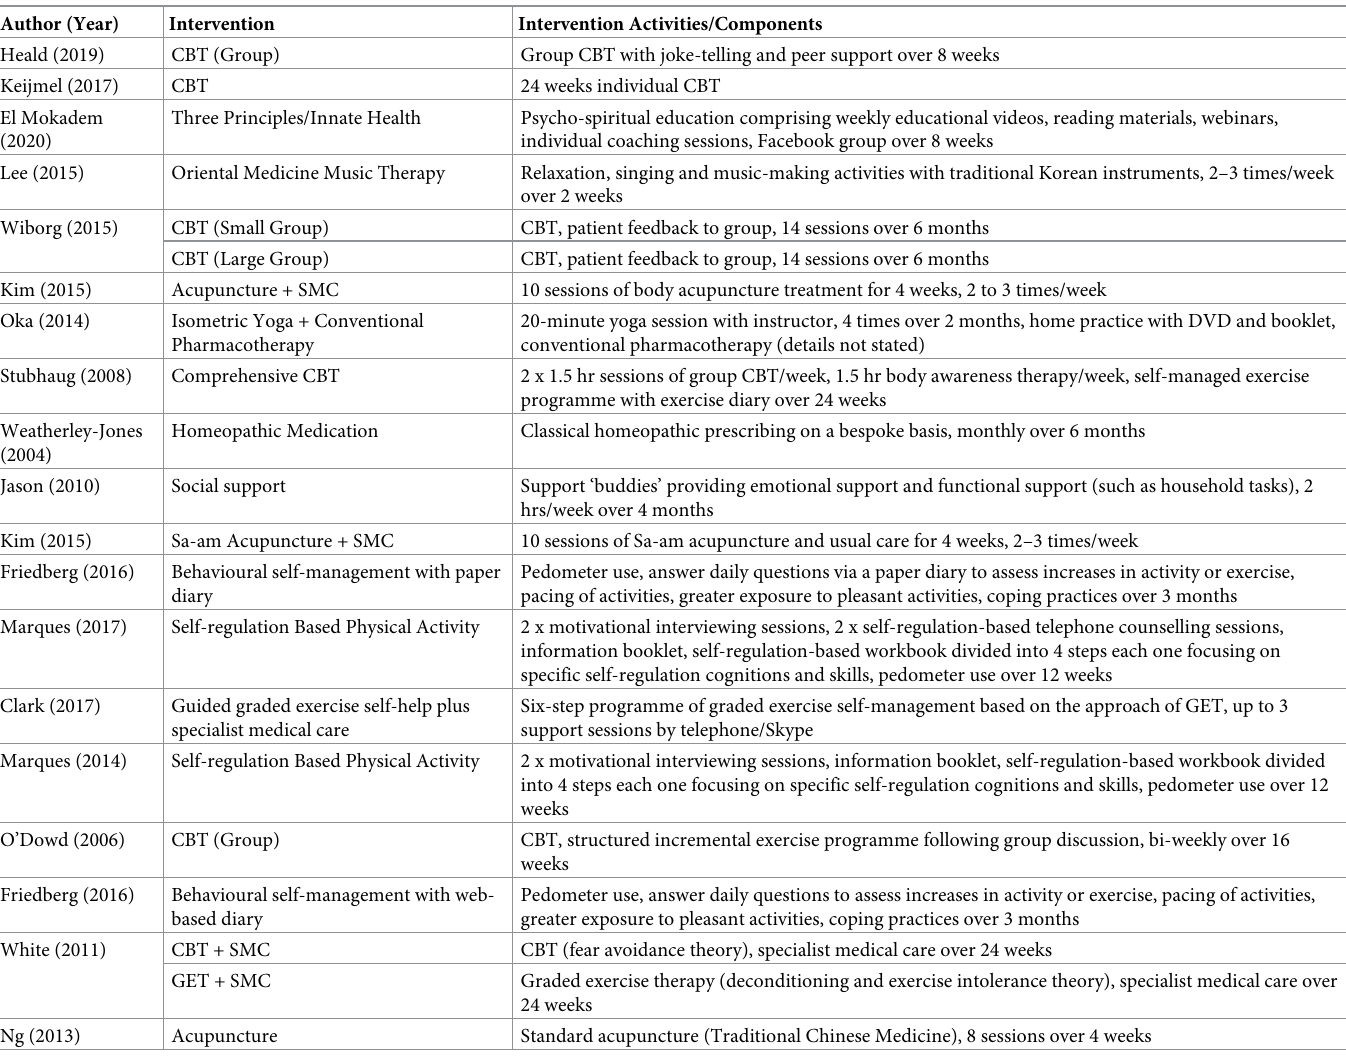
Table 2. Name of intervention with specific activities and